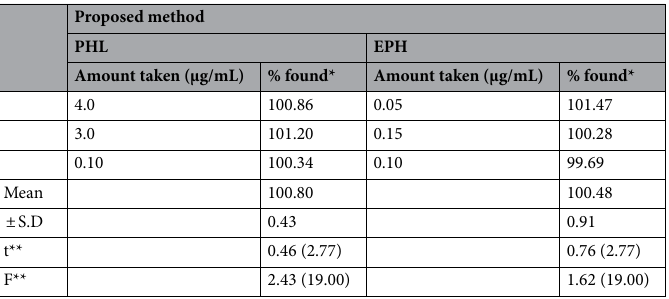
Table 4. Analysis of laboratory prepared mixtures of pholcodine and ephedrine using synchronous spectrofluorimetric method (Method II). *Each result is average of 3 separate determinations. **Values between parentheses are the tabulated values of t-test and F-test at p = 0.05 50